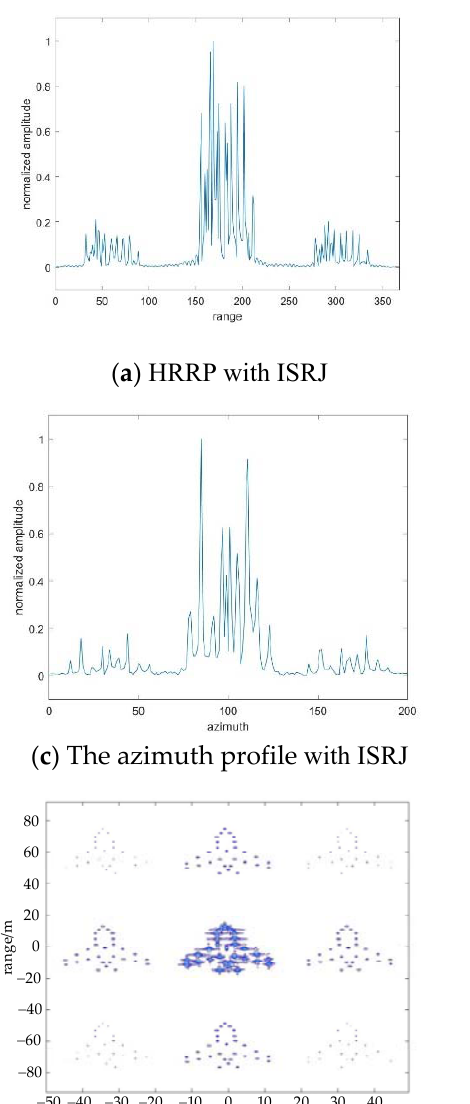
( f ) The ISAR image after anti ‐ jamming Figure 7. The results of ISRJ jamming and anti ‐ jamming in the fast time domain, slow time domain, Figure 7. The results of ISRJ jamming and anti-jamming in the fast time domain, slow time domain, M M 16 4 . and ISAR image when   ， and ISAR image when M d = 16, M a = d a